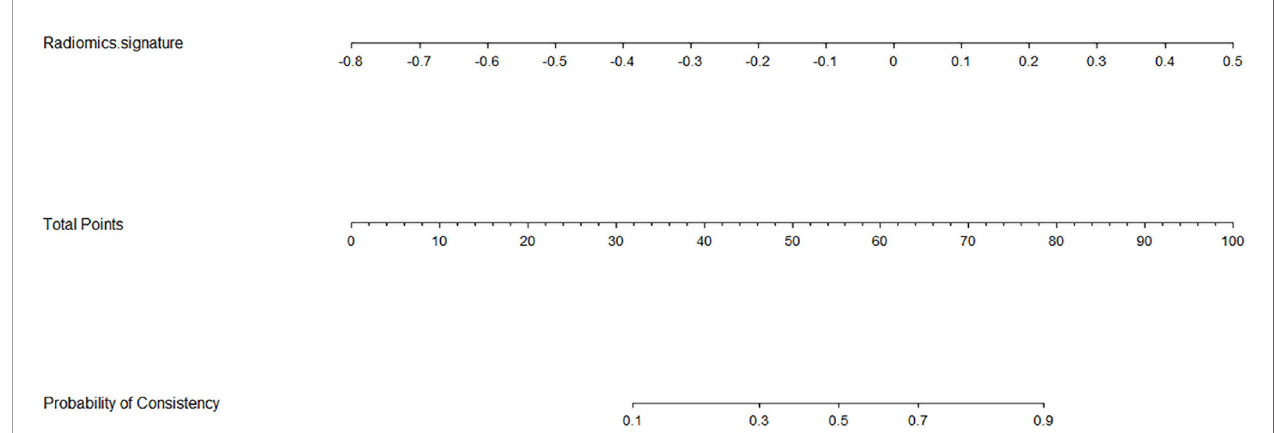
FIGURE 3 | Radiomics nomogram for the meningiomas consistency. As an example, if one patient had the radiomics signature of -0.2, the corresponding total points was about 46, which corresponding to a 30% probability of a fi rm meningioma. That ’ s to say, using the nomogram, the patient ’ s meningioma consistency was predicted to be soft before surgery.